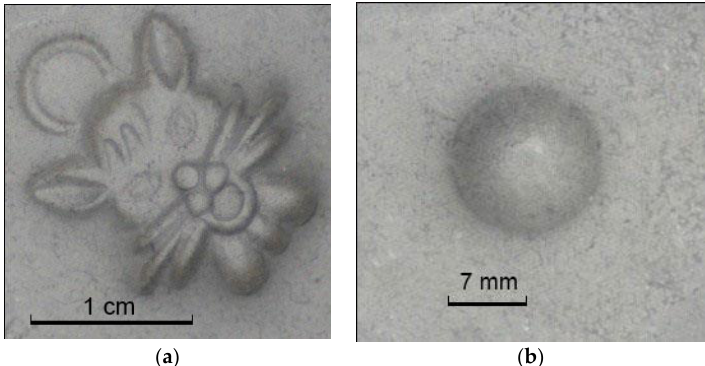
Figure 3. The 2-D surface deformation when the robotic finger touches different objects: ( a ) small mascot; ( b ) rigid sphere.